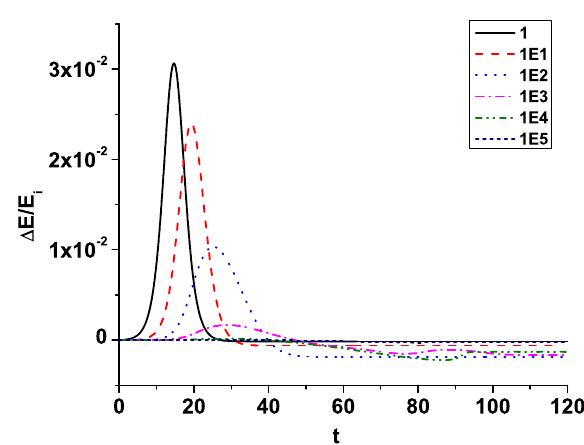
Figure 5 . The relative change in energy of the object, ∆ E/E i , in the collision process with the wall as a function of time. The parameters are chosen to be A = 0 . 5 , initial v O = 0 . 1 , R = 1 . 5 , while the values for the object’s mass m are marked in the plot. As an object is approaching the wall its energy is increasing. Since the value of the scalar field at the object’s location is increasing during the approach, the effective mass of the object, M , is increasing. Thus the energy of the object is increasing. During and after the interaction, the energy is decreasing since the velocity is decreasing, and also some of the energy is used to deform the wall. For medium mass cases, the object regains some energy when the wall bounces back (e.g. for M = 10 3 ), so energy is increasing again at late times.